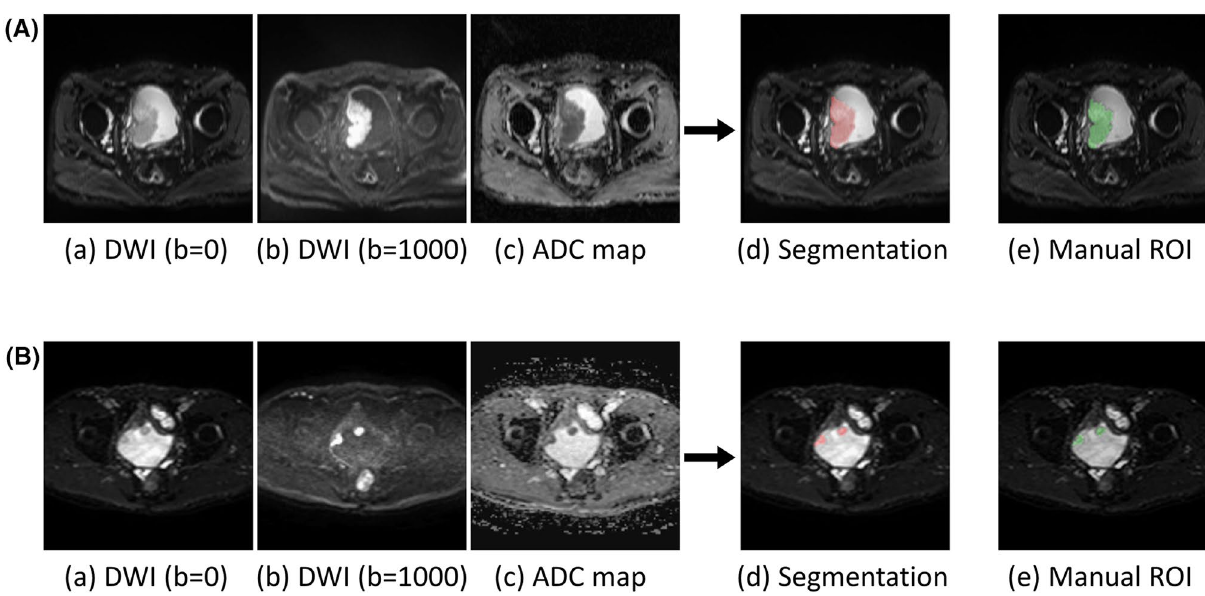
Figure 4. Two representative cases of automatic segmentation of bladder cancer in the test dataset (case 1 ( A ); case 2 ( B )). ( a ) Diffusion weighted image with b = 0 s/mm 2 , ( b ) diffusion weighted image with b = 1000 s/ mm 2 , ( c ) apparent diffusion coefficient map, ( d ) results of automatic segmentation overlayed on diffusion weighted image with b = 0 s/mm 2 , ( e ) manual region of interest for the reference standard. The large tumor was almost perfectly segmented in case 1 (Dice similarity coefficient = 0.95), and the two distant tumors were well segmented in case 2 (Dice similarity coefficient =